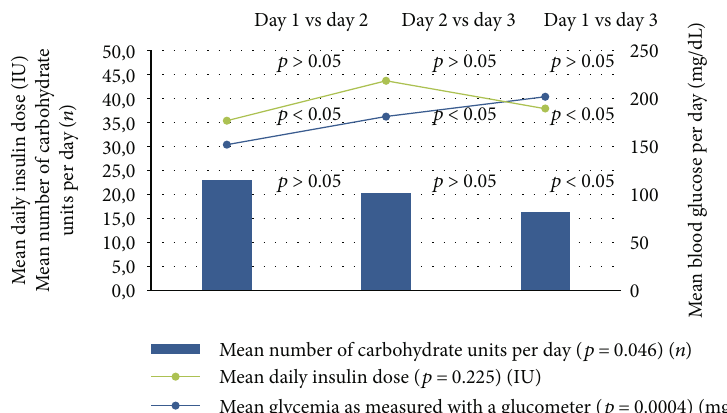
Figure 1: The relationship between mean glycemia, mean carbohydrate unit intake, and daily insulin dose on each expedition day (with p values for the comparison between the 3 expedition days).